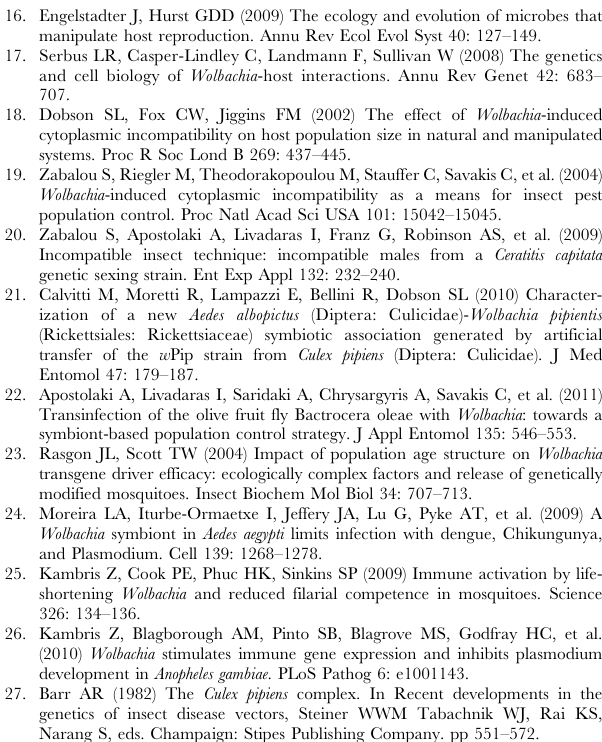
Figure S1 Backcrossing procedure. Mosquito nuclear backgrounds are indicated by colours: black represents Cx. p. quinquefasciatus nuclear background (LR and LR-TC lines) and red represents Cx. p. pipiens nuclear background (Is line). Wolbachia infection types are indicated by w-labelled symbols: black-filled symbols represent the w Pip(LR) strain and red-filled symbols the